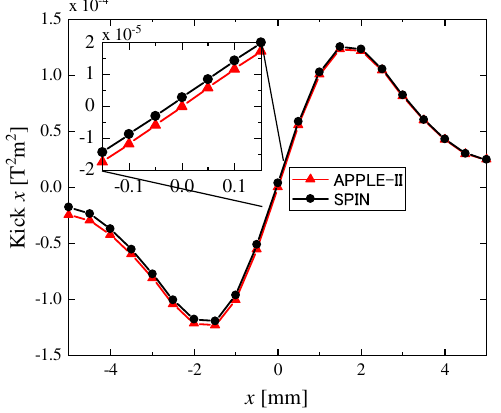
FIG. 8. Comparison between the APPLE and SPIN undulators in terms of horizontal kick map calculated at the gap of 4 mm.